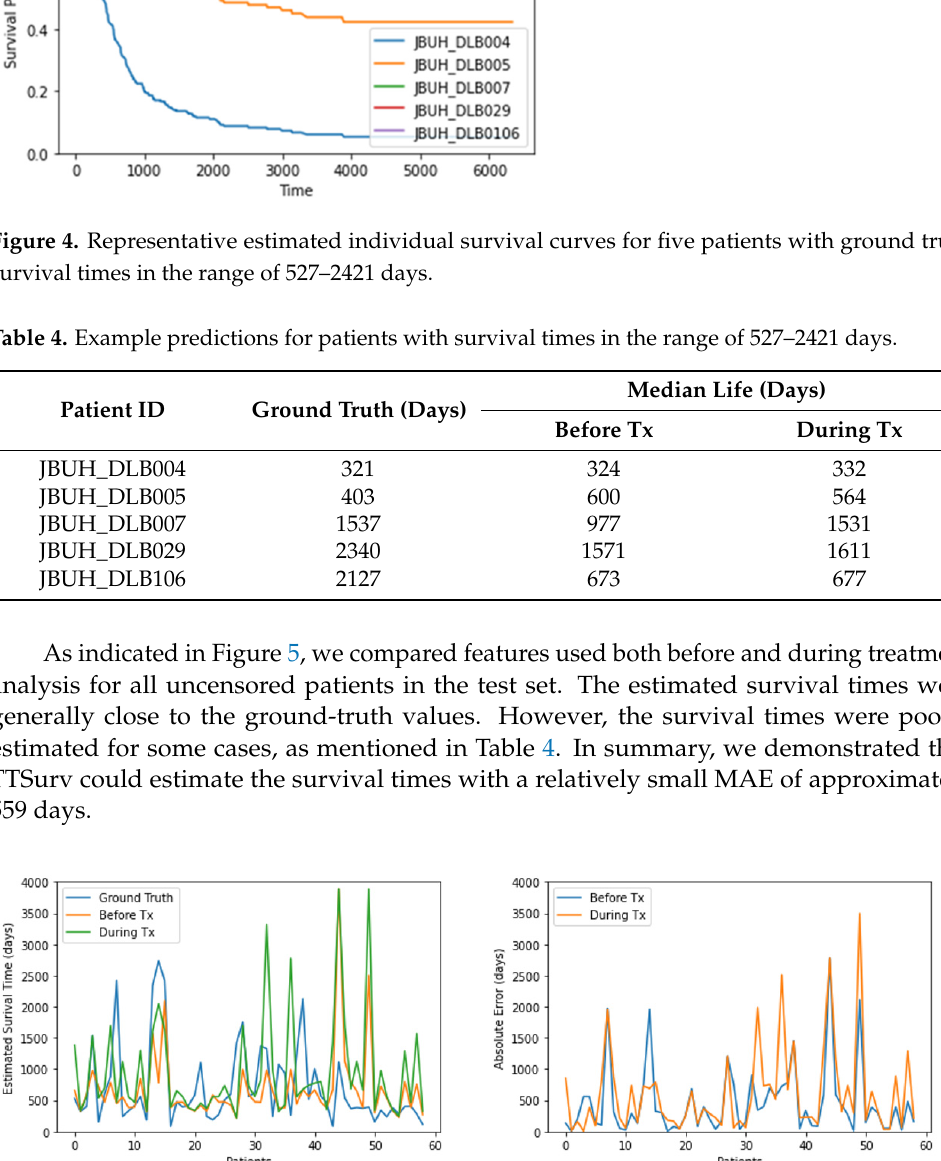
Figure 4. Representative estimated individual survival curves for fi ve patients with ground truth